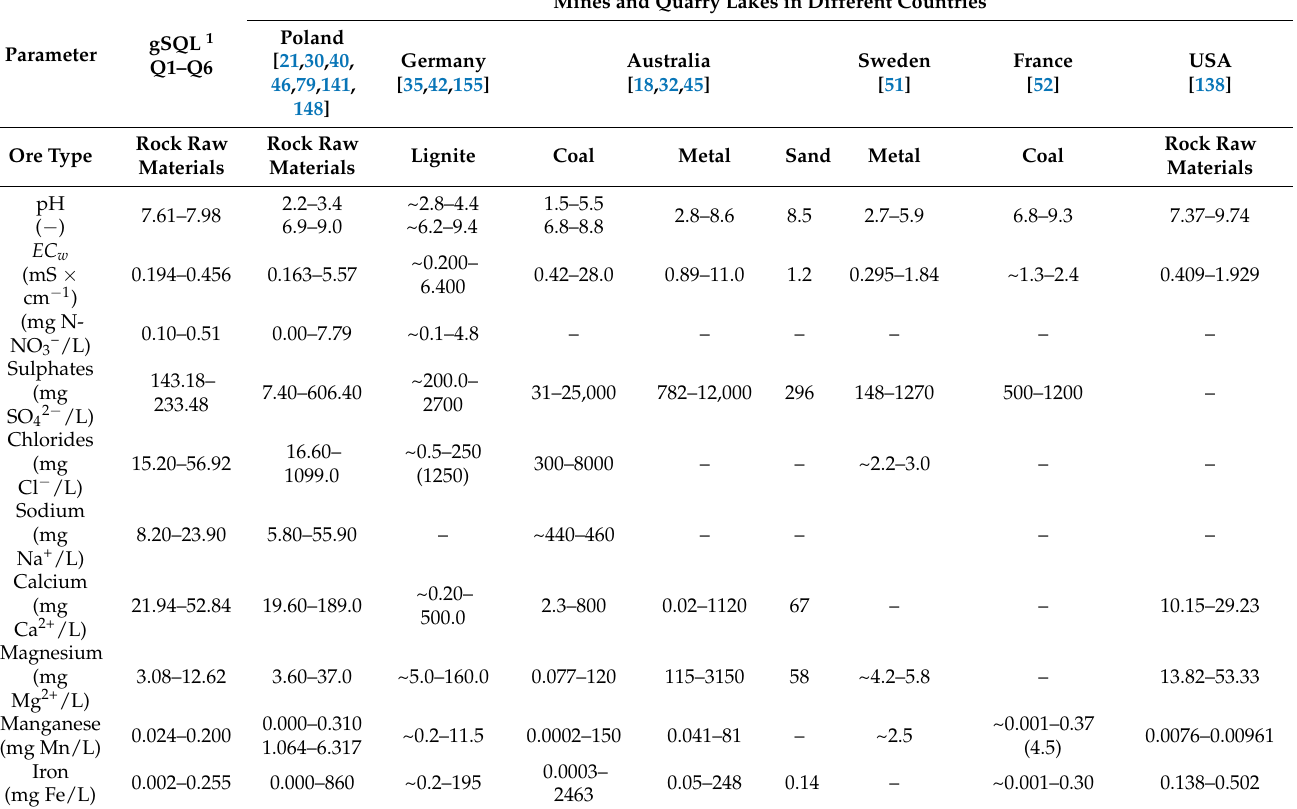
Table 4. The comparison of the range of averages values and concentrations of selected water indicators in the analysed Strzelin quarry lakes (gSQL) vs. other mines lakes, and quarry lakes and ponds. (author